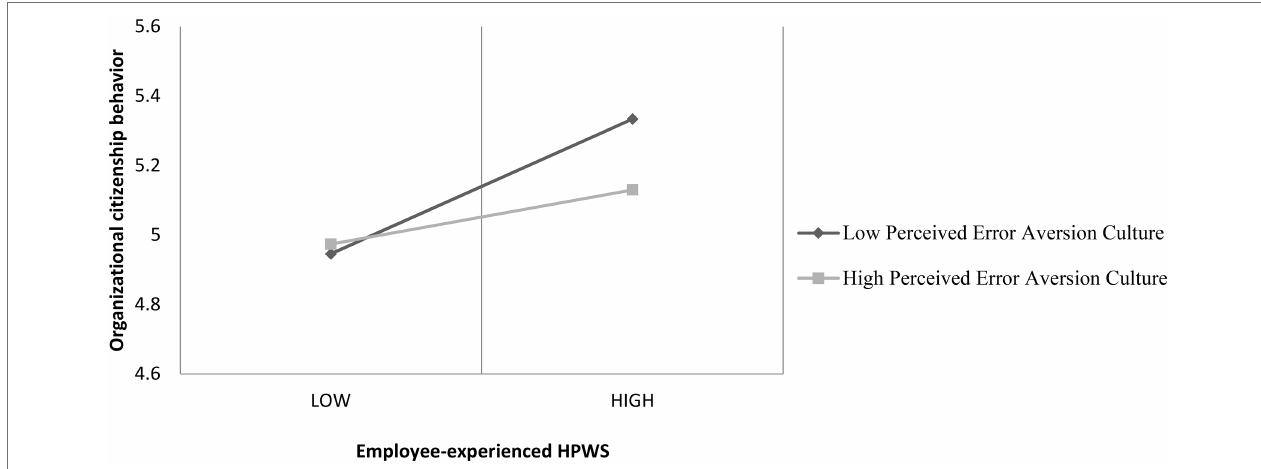
FIGURE 2 | The moderating effects of perceived error aversion culture on the HPWS-OCB relationship.